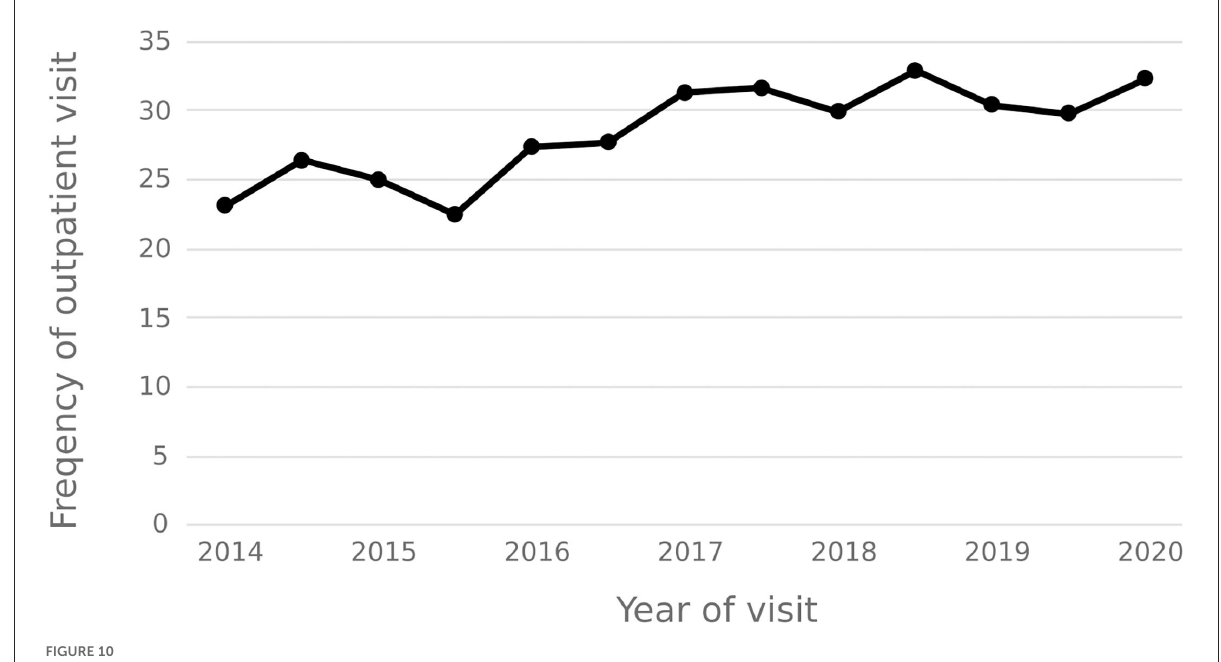
FIGURE10 Average frequency of outpatient visit of patient per